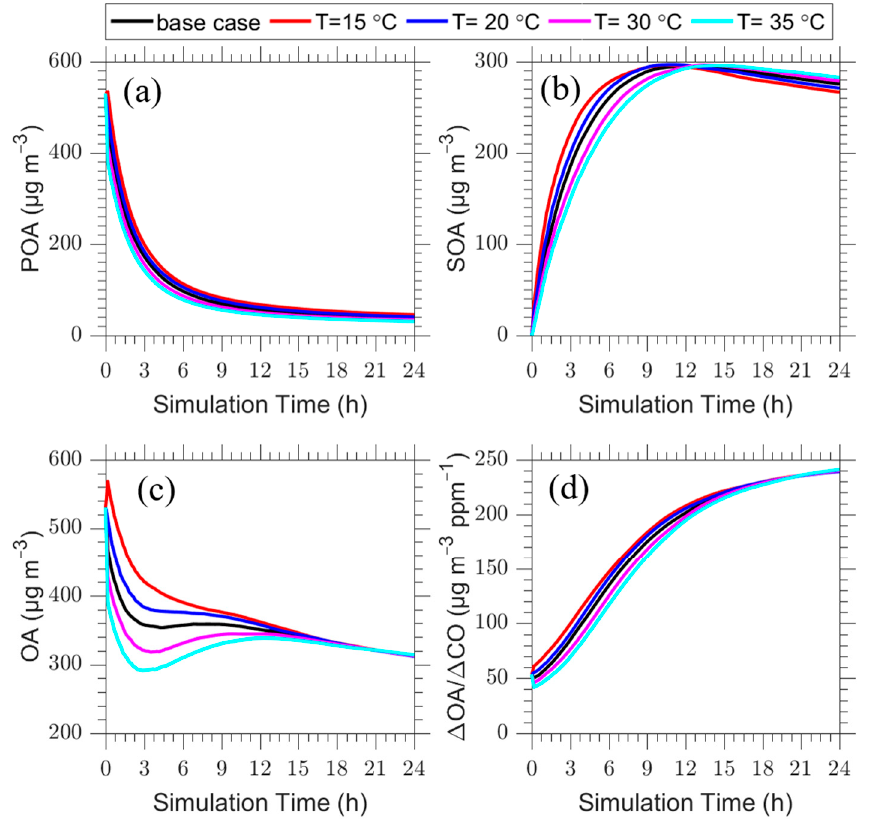
Figure 5. Time series of: ( a ) POA; ( b ) SOA; ( c ) total OA; and ( d ) Δ OA/ Δ CO for the plume centerline for the base case (T = 25 °C) ( black line ) and the cases with temperature equal to 15 °C ( red line ), 20 °C ( blue line ), 30 °C ( magenta line ) and 35 °C ( cyan line ).